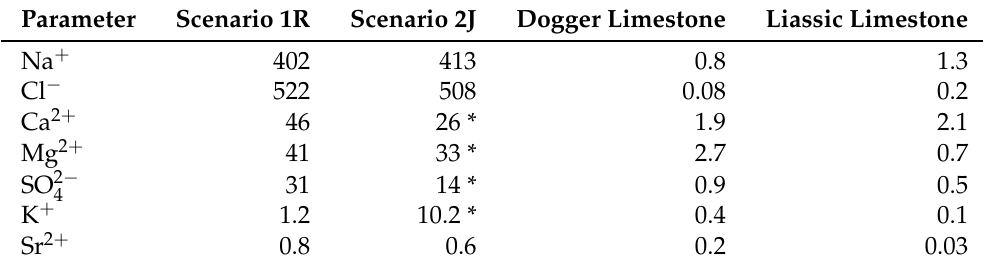
Table 1. Concentrations of the main ions (mmol/L) for the two scenarios regarding the initial conditions prior to activation of the aquifers as well as for the present-day waters of bounding aquifers in the Dogger and Liassic. Scenario 1R is based on a sample from the Opalinus Clay taken at Mont Russelin [23]. Scenario 2J is a combination of Liassic groundwater at Mont Russelin [23] and Jurassic sea water (indicated by *)